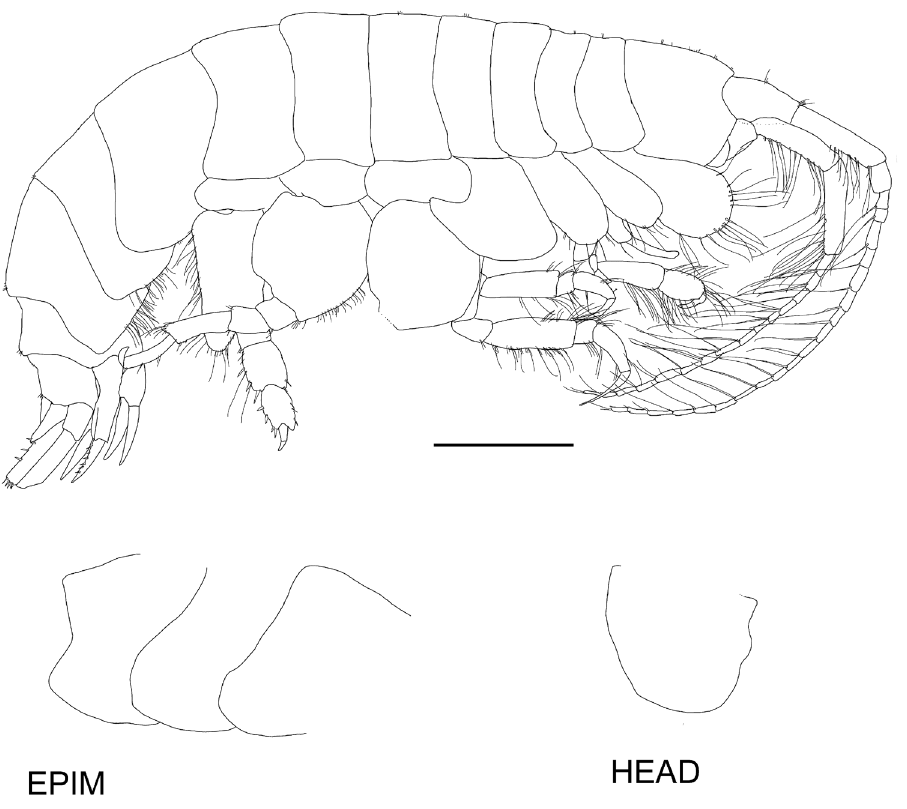
Figure 5. Haploops dauvini sp. n., holotype, female, 7 mm, ZMH K-47038, Norwegian Channel, 587.4–614.4 m. Whole animal, head and epimeron. Habitus scale represents 1 mm.